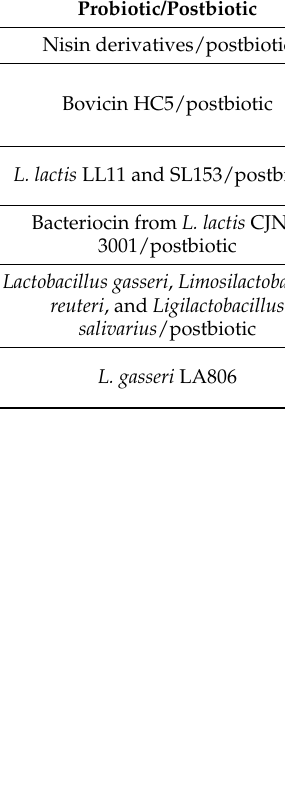
Table 3. Overview of the application of potential probiotic bacteria in bovine farming in an in vitro study.